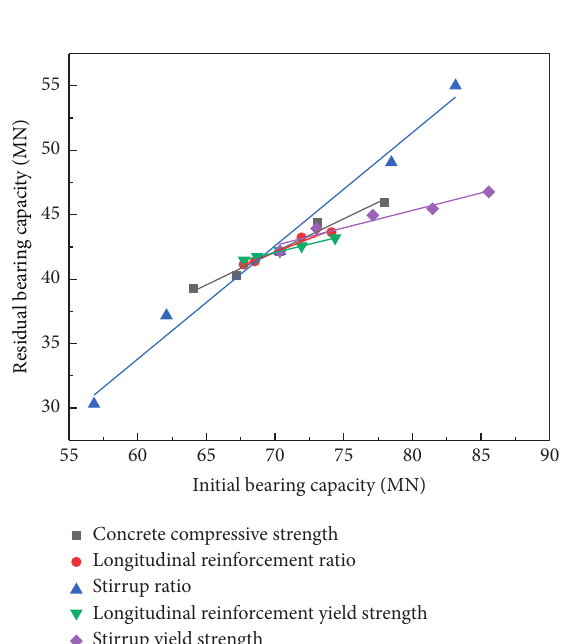
Figure 12: Linear regression graphs for different